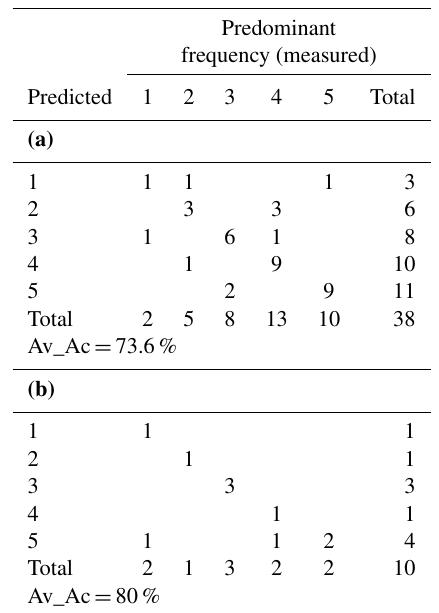
Table 4. Comparison between the model’s output and the measured predominant frequency in Bam City by (a) Motamed et al. (2007) and (b) LashkariPour et al. (2006).